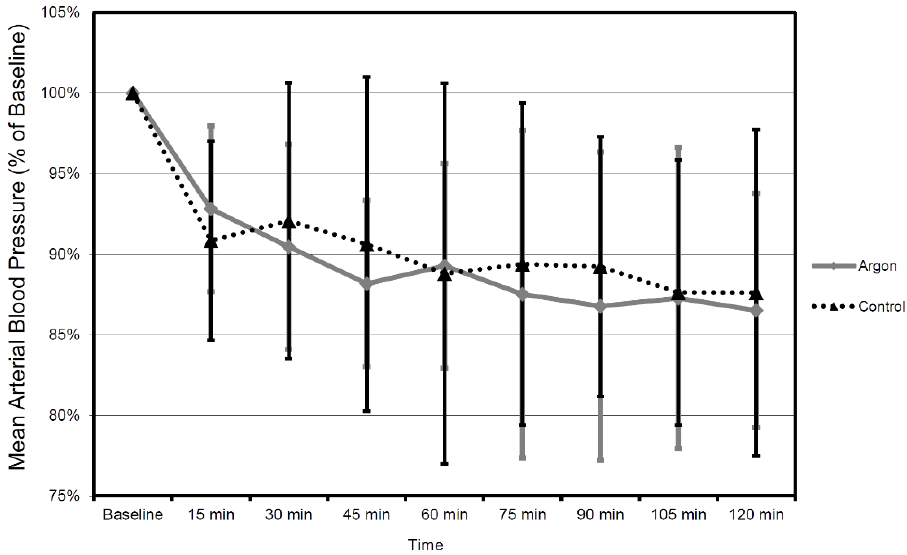
Figure 8. Mean arterial blood pressure (MAP) values in time course 2 h after trauma in 15 min intervals. All values in relation to baseline 30 min prior to trauma (mean ± SD). Therapy was administered until 2 h after trauma (the number of animals were as follows: Argon = 9, Control = 9).